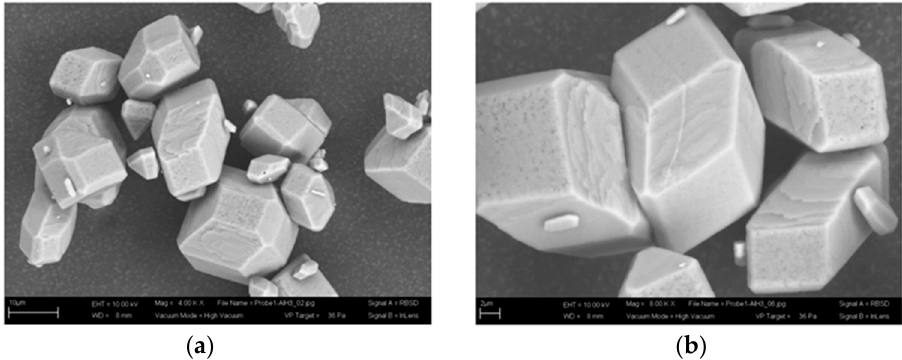
Figure 3. SEM pictures of α (cid:3398) AlH (cid:2871) . ( a ) and ( b ) are SEM pictures pictures of α (cid:3398) AlH (cid:2871) at different magnification. Reprinted with permission from ref. [28]. Copyright 2009 WILEY ‐ VCH Verlag GmbH & Co. KGaA, Weinheim.